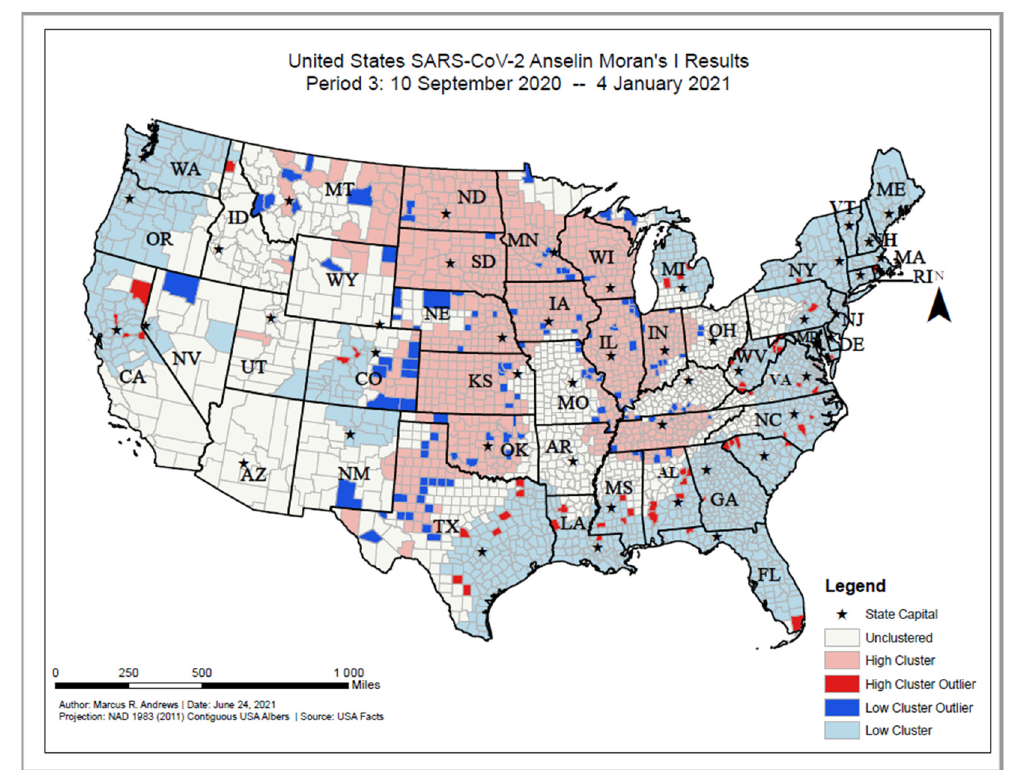
Figure 7. United States SARS-CoV-2 Anselin Moran’s I results, Period 3: 10 September 2020–4 January 2021.